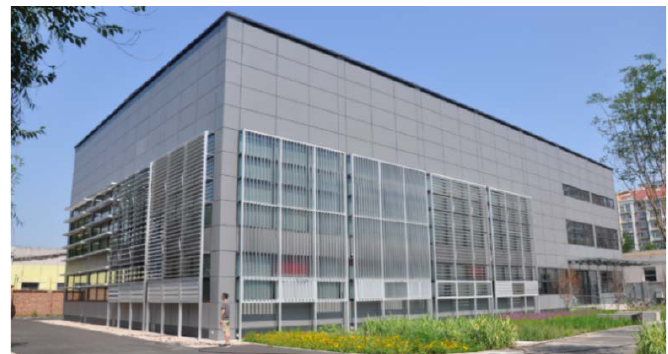
Figure 1. Lab Exterior View.